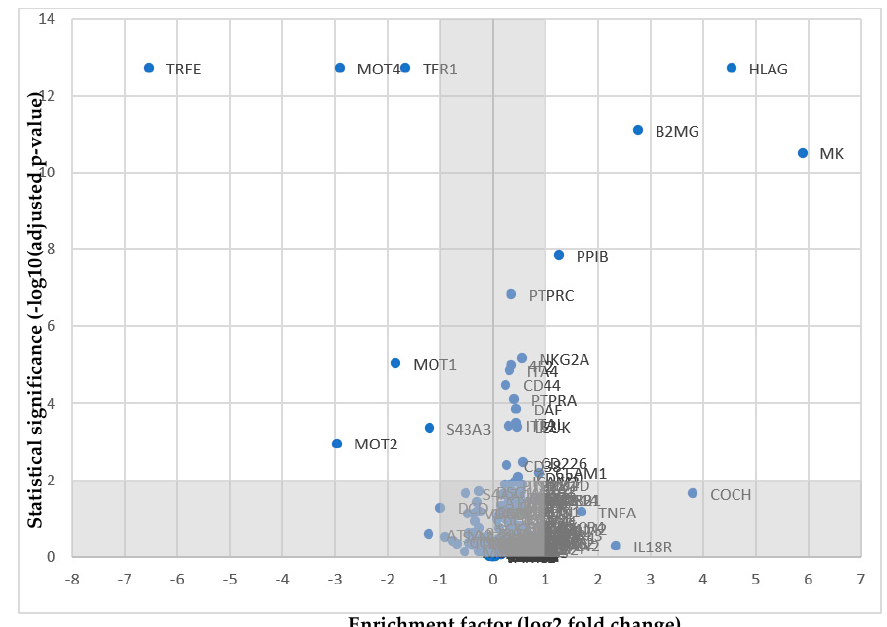
Figure 1. Ligand-based receptor capture was performed using NKL cells as target cells in order to identify receptors for sHLA-G. The TriCEPS -construct was bound to the ligand of interest sHLA-G or to the positive control transferrin before binding of the coupled molecules to periodate-oxidized NKL cells. The cells were lyzed, proteins digested and the TriCEPS -construct was purified. After the enzymatic peptide release the peptides were analyzed via mass spectrometry. The results of the final TriCEPS experiment are depicted in a volcano plot showings the enrichment of possible receptors for the positive control transferrin (left) and the ligand of interest HLA-G (right). On the y-axis the statistical significance is indicated ( − log10 (adjusted p -value)). On the x-axis the enrichment factor (Log2 fold change) between the two conditions is shown. A statistical significance of at least 2 and an enrichment factor of 2 fold and greater is required.